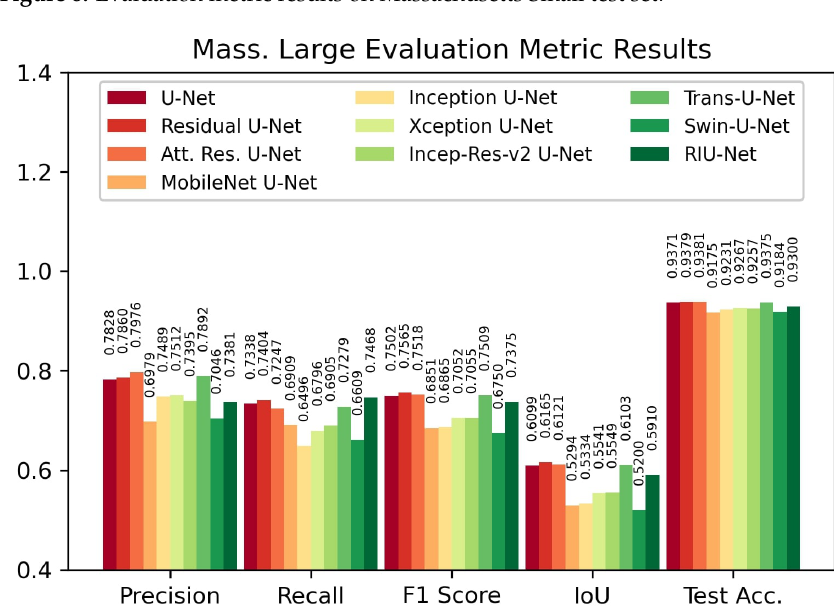
Figure 9. Evaluation metric results on Massachusetts Large test